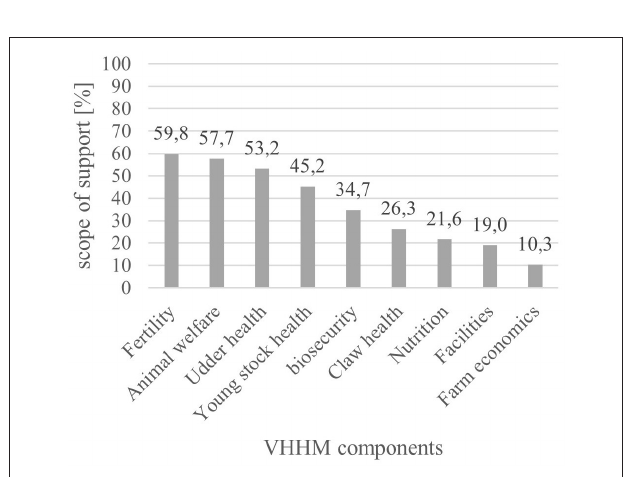
FIGURE 2 | Bar chart: Scope of VHHM